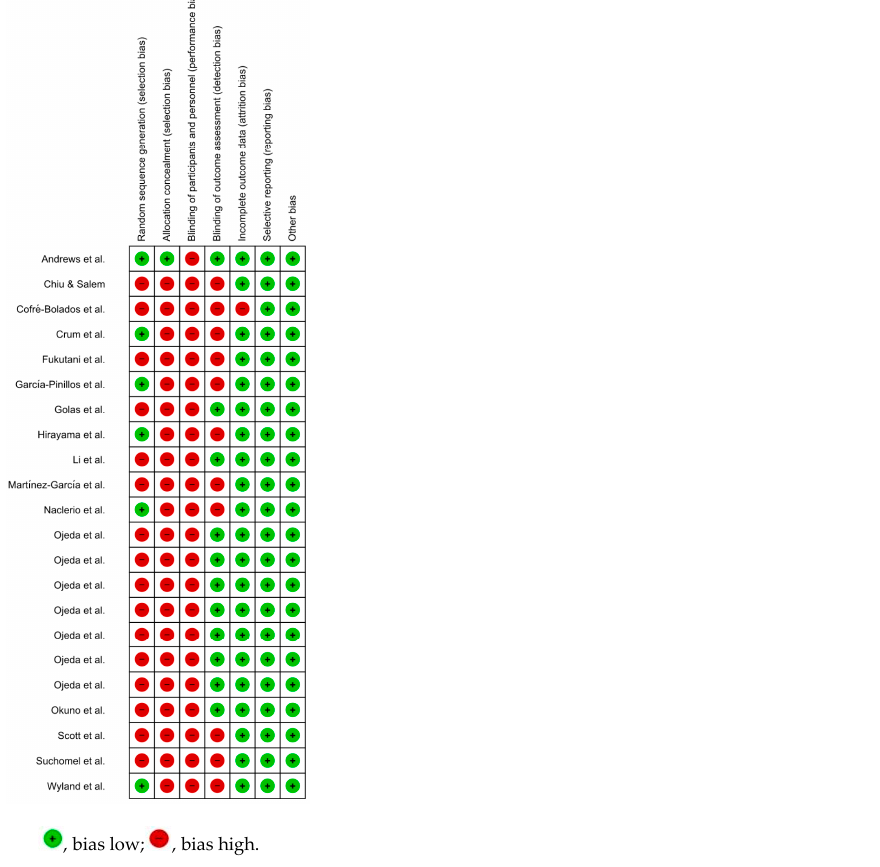
Figure 3. Risk of bias summary: review authors’ judgments about each risk of bias item for each included study [28–49].